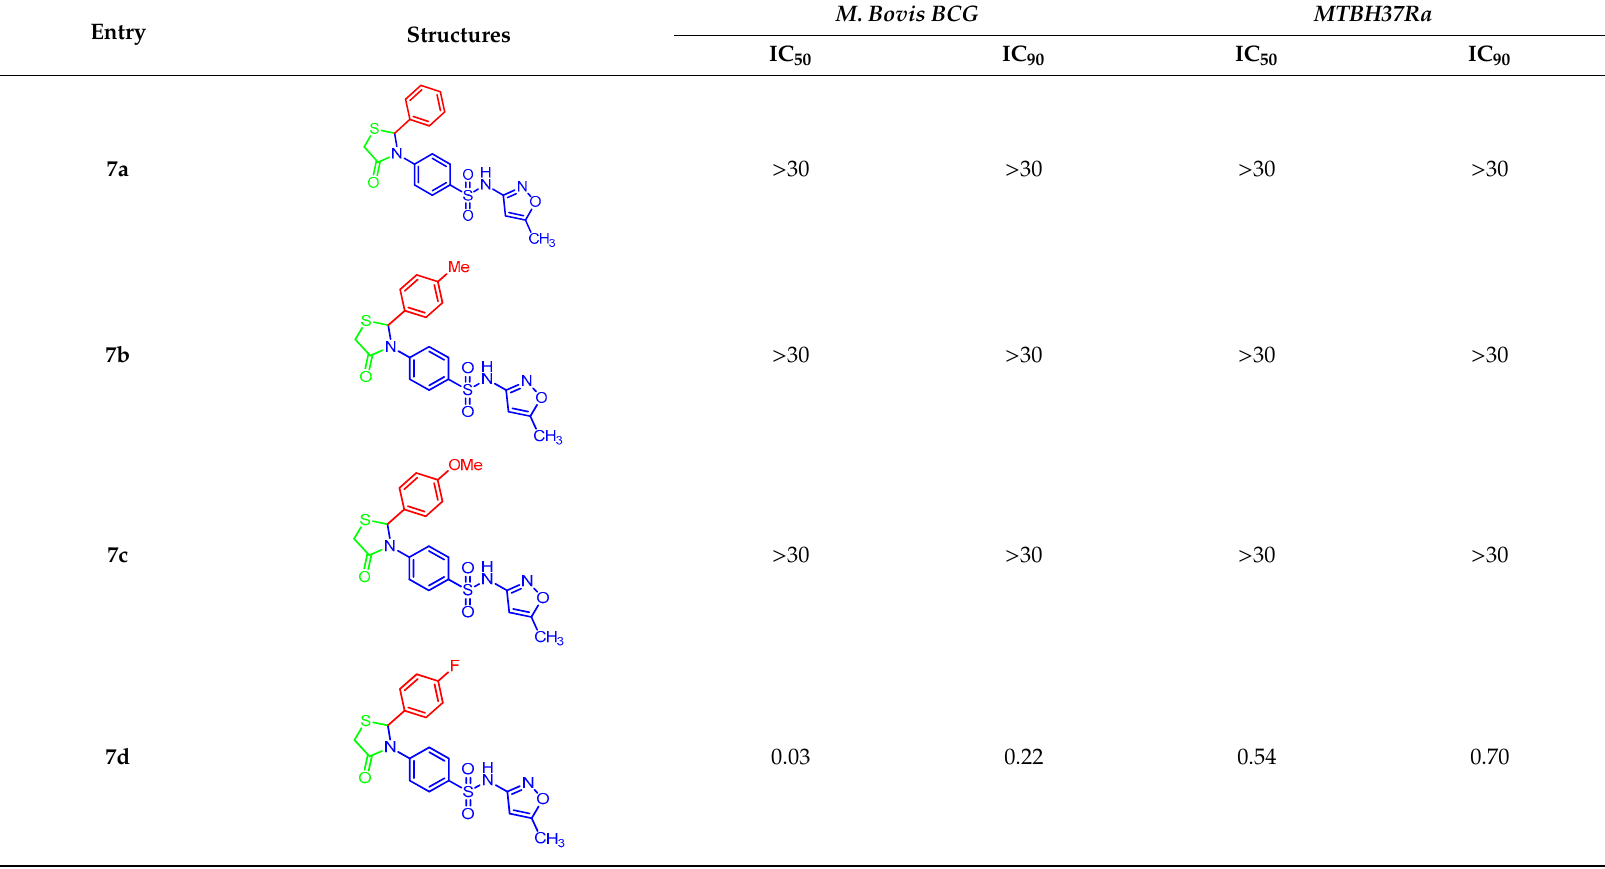
Table 1. Anti-mycobacterial activity of the sulfamethaoxazole incorporated 4-thiazolidinones a .